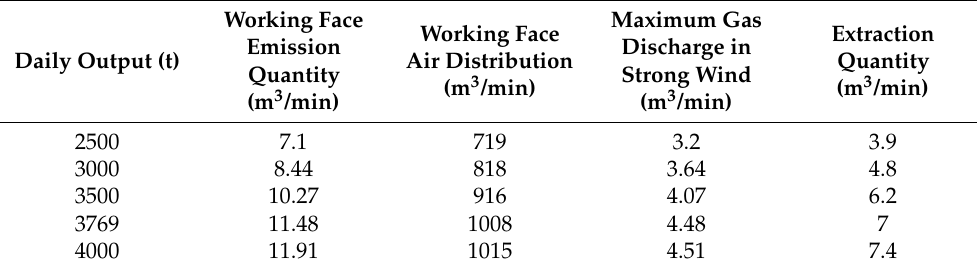
Table 5. Relation between daily output, gas content, air distribution volume and high-level borehole drainage volume of XV1306 working